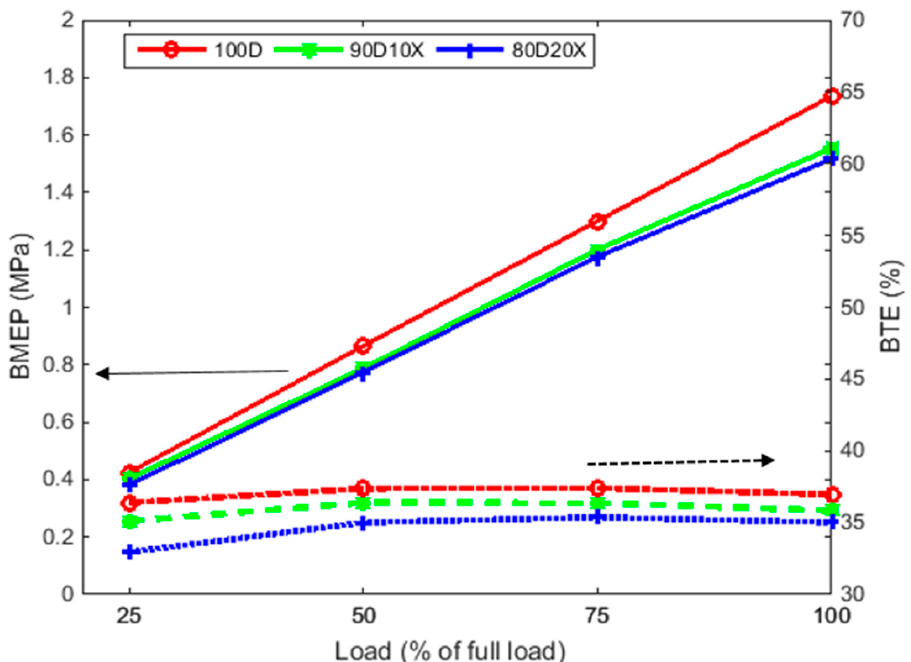
Figure 3. Variation of brake thermal efficiency and brake mean effective pressure with engine loads for different fuels.